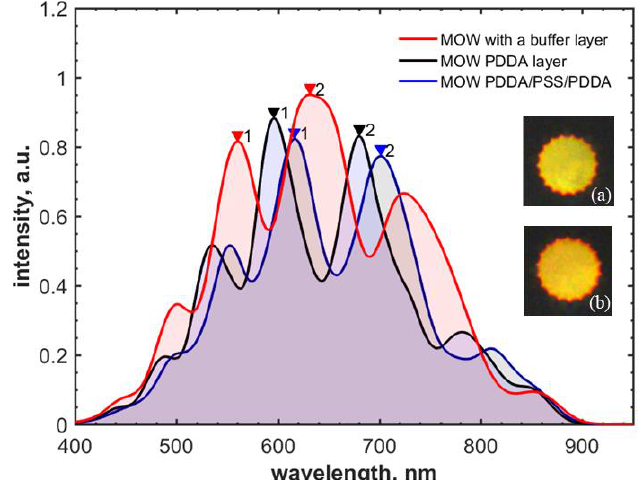
Figure 13. Transmission spectra for MOWs coated with the buffer layer only (red) and with two layers of 300-nm silica particles over PDDA (black) and PDDA/PSS/PDDA (blue) intermediate layers. The inserts are the mode profiles of MOW samples modified by two layers of 300-nm silica particles over PDDA ( a ) and PDDA/PSS/PDDA ( b ) intermediate layers. Table 4. Spectral shift of local transmission bands for two layers of 300-nm silica particles over PDDA or PDDA/PSS/PDDA intermediate layers.